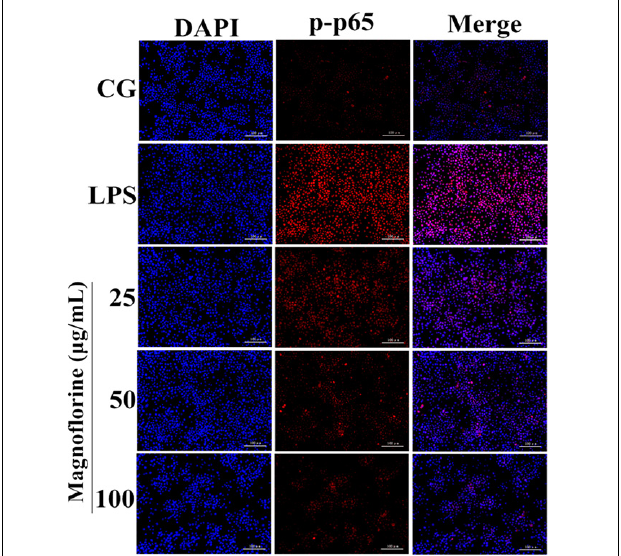
FIGURE 7 | Effects of magnoflorine on p65 translocation into the nucleus. Translocation of the p65 subunit from the cytoplasm into the nucleus was assessed by immunofluorescence staining ( × 200), scale bar = 100 µ m. Blue spots represent cell nuclei, and red spots indicate p-p65 staining. CG is the control group. LPS is the LPS-stimulated